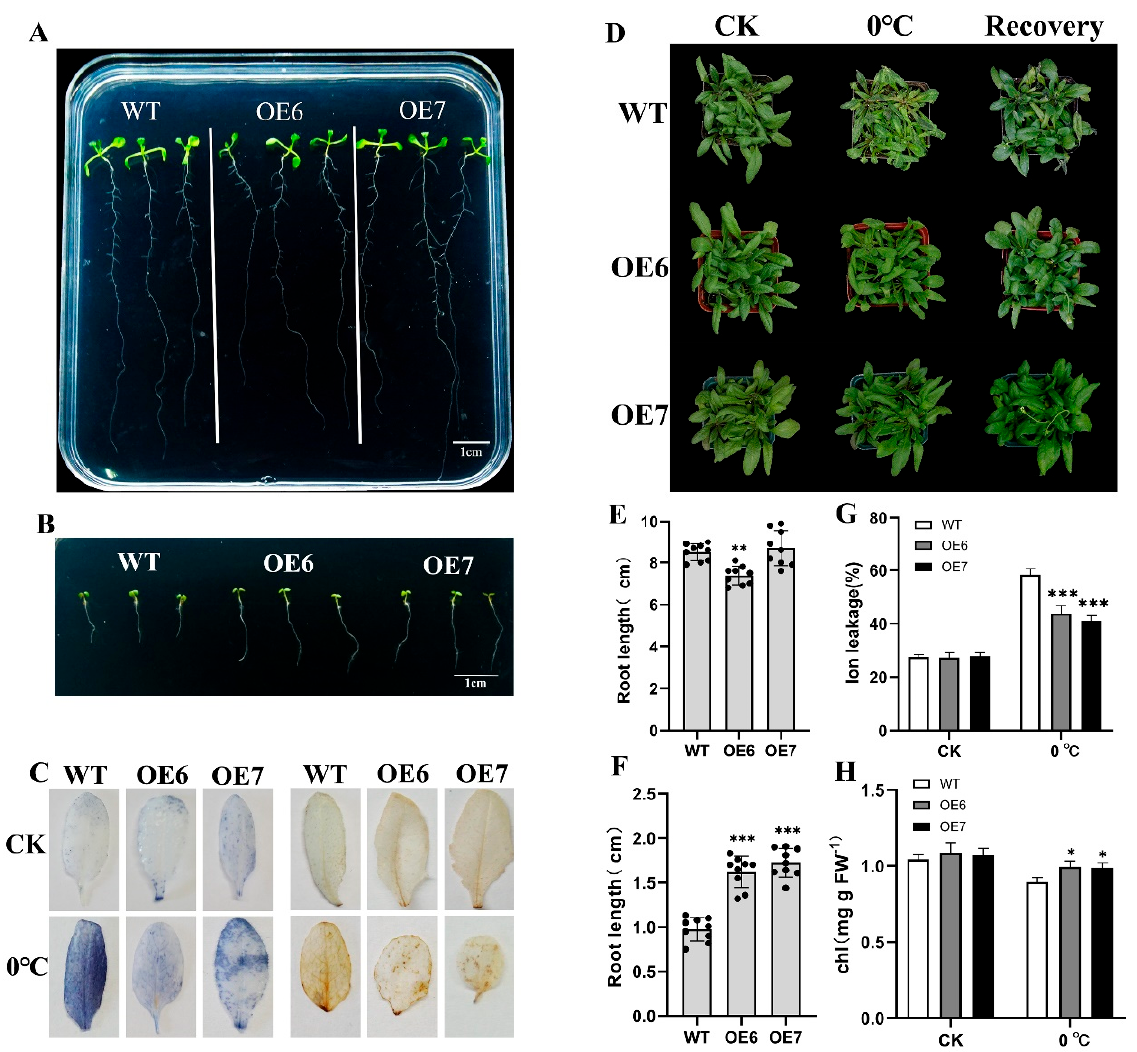
Figure 5. The phenotypes of wild-type and transgenic Arabidopsis at low temperature. ( A ) Root growth of WT and transgenic lines at 23 ◦ C for 10 days. ( B ) Root growth of WT and transgenic lines at 4 ◦ C for 10 days. ( C ) NBT and DAB staining. ( D ) WT and transgenic lines were treated at 0 ◦ C for 5 days and then recovered at 23 ◦ C for 3 days. ( E ) Root length of WT and transgenic lines at 23 ◦ C for 10 days. ( F ) Root length of WT and transgenic lines at 4 ◦ C for 10 days. Data are shown as mean ± SD of nine wild-type or T3 transgenic plants ( n = 9). ( G ) Ion leakage. ( H ) Total chlorophyll content. Error bars, ± SD. Each analysis was repeated with three biological replicates. Asterisks denote significant differences (as compared with the WT): * p < 0.05; ** p < 0.01; *** p < 0.001. WT, wild-type. OE, overexpression lines. CK, Control Check.